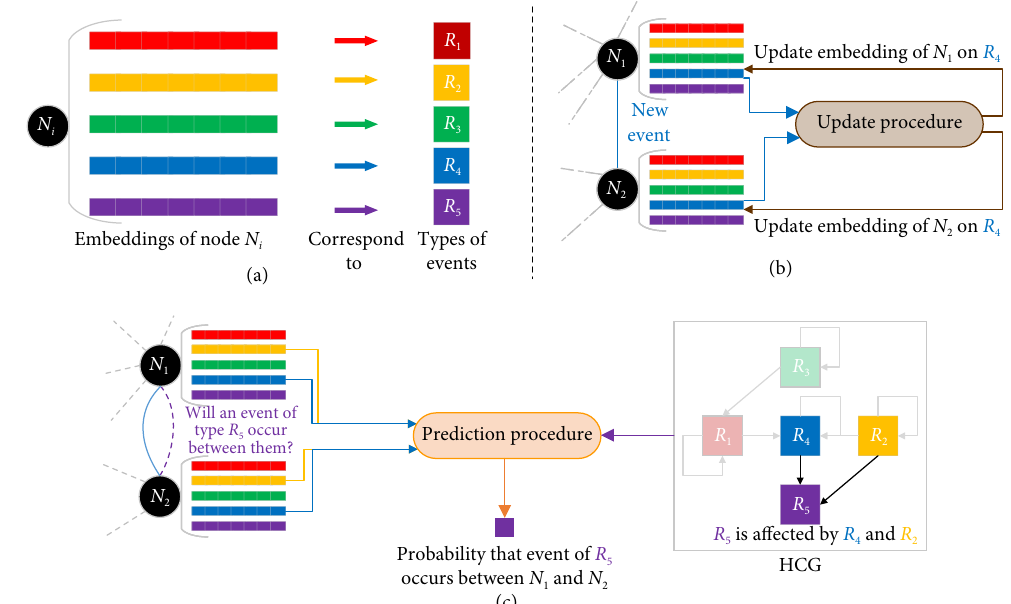
Fig. 3 Schematic diagram of ECHN. (a) Node N i has five embeddings and each embedding corresponds to one event type. (b) After the occurrence of an event of type R 4 , ECHN updates the embeddings of N 1 and N 2 corresponding to R 4 via the update procedure. (c) The prediction procedure is performed under the guidance of the HCG to predict the occurrence probability of an event between N 1 and N 2 for type R 5